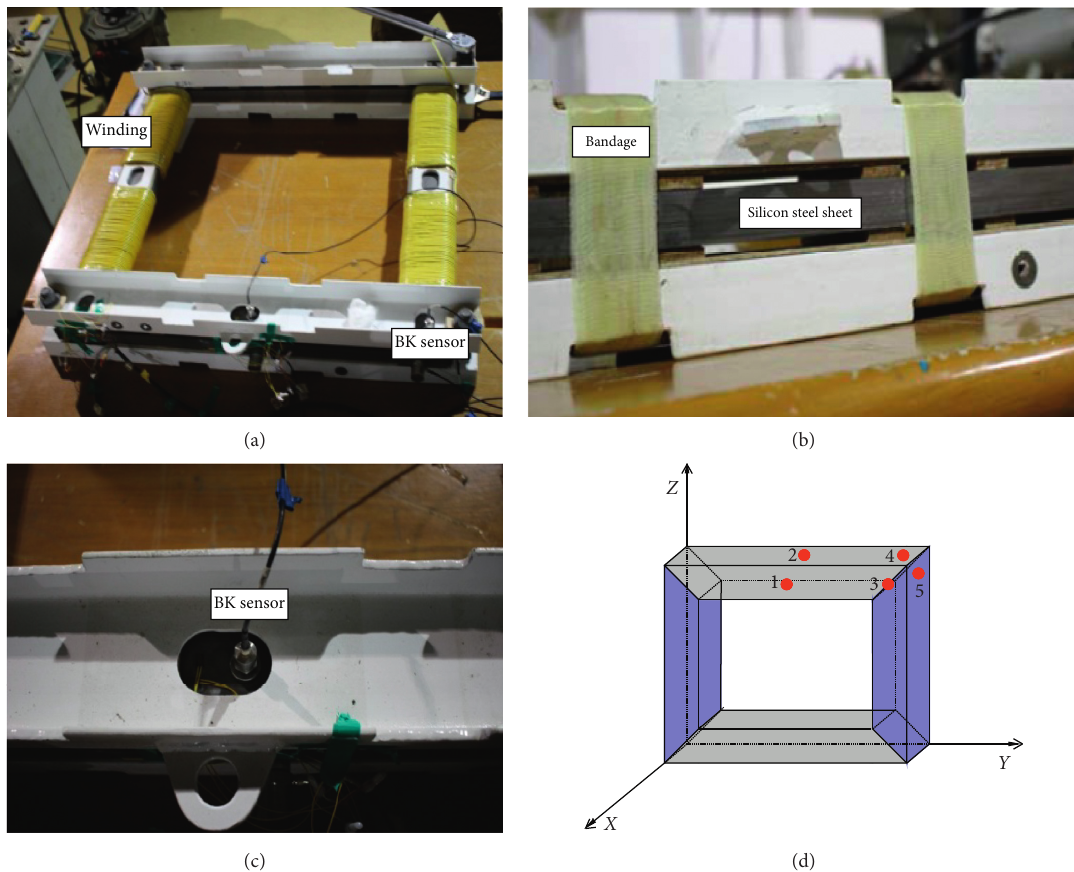
Figure 2: Four-corner iron core model test platform. (a) Top view. (b) Side view. (c) Vibration sensor. (d) Acceleration measurement